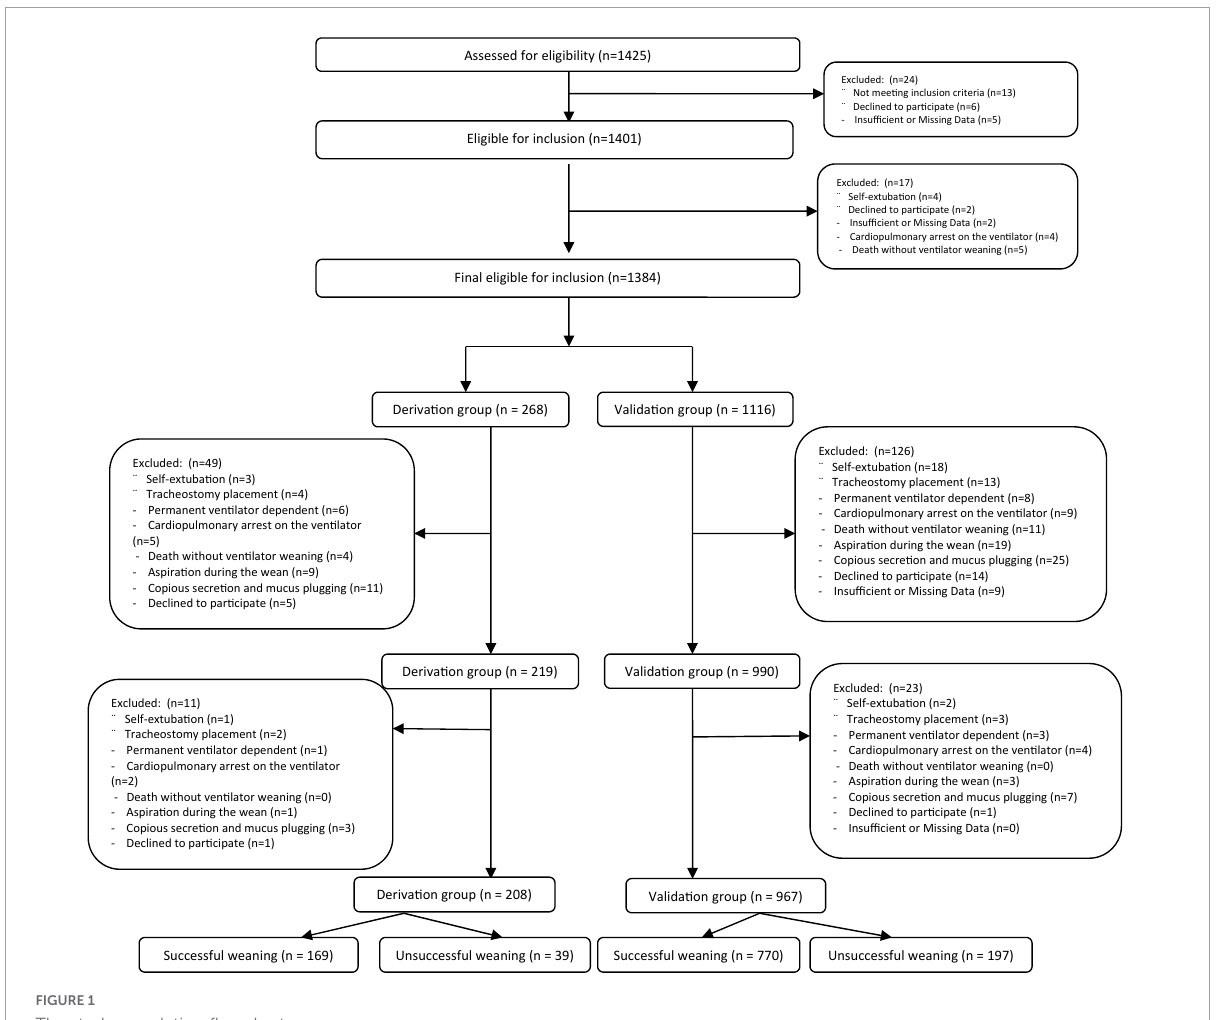
FIGURE1 The study population